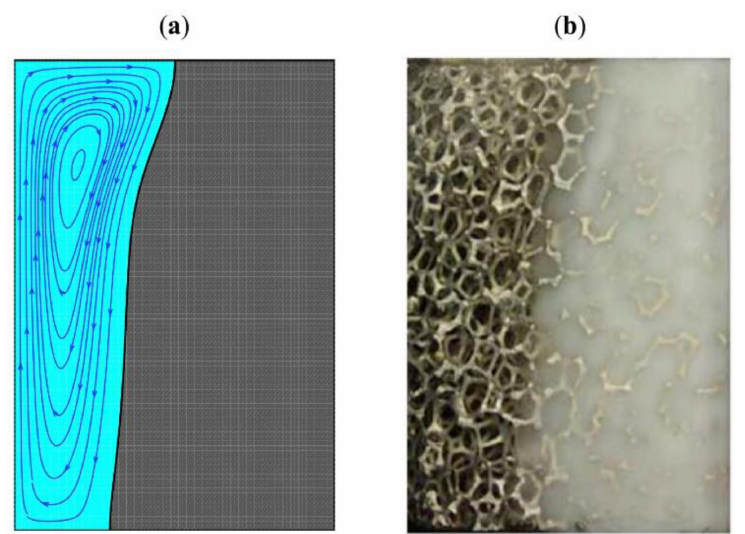
Figure 4. Melted domains of the phase change material: ( a ) numerical result of the current model and ( b ) experimental observation by